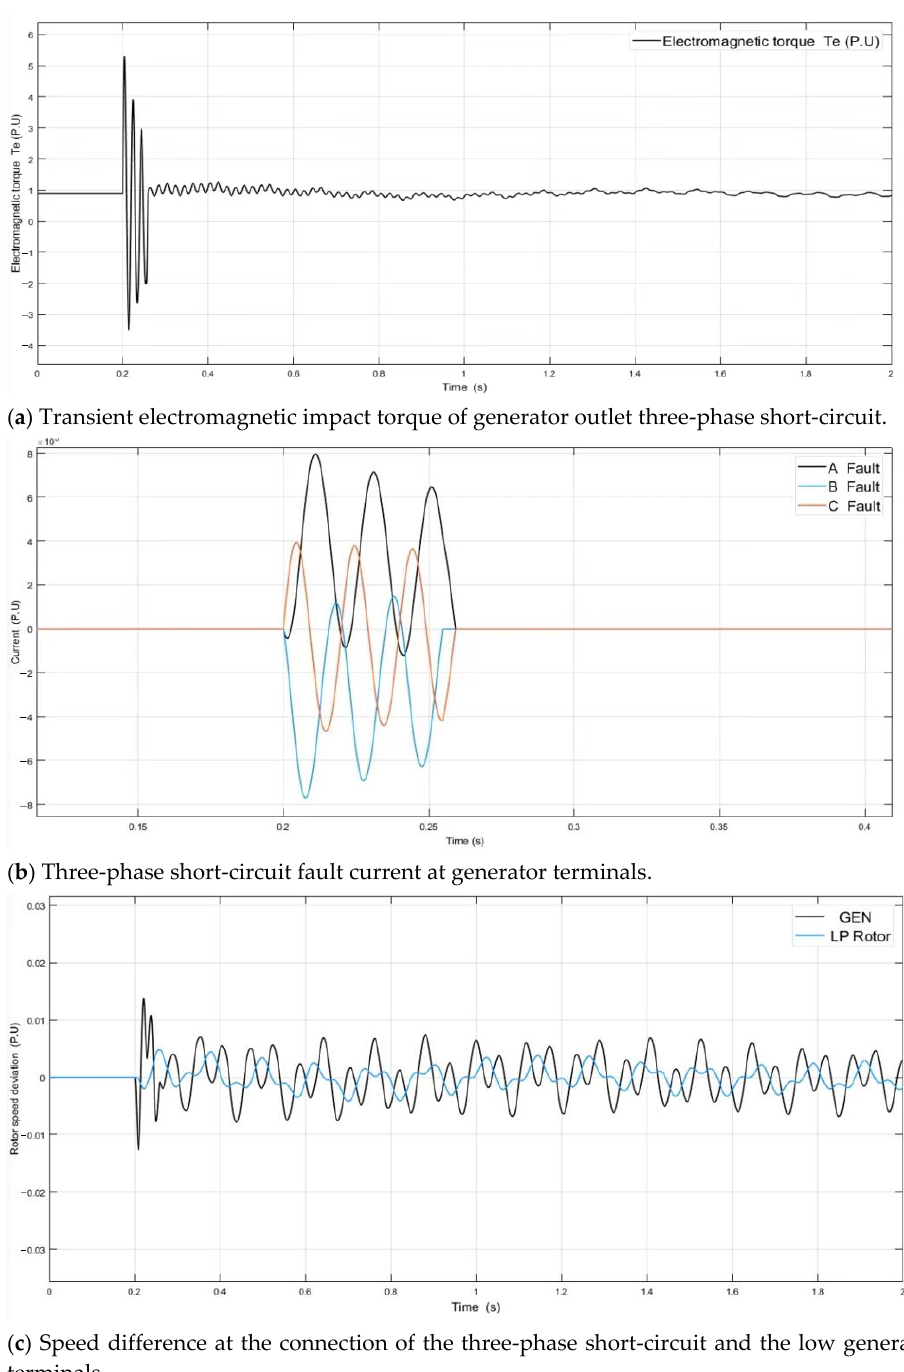
Figure 7. Characteristic curve of generator terminal’s three-phase short-circuit fault.